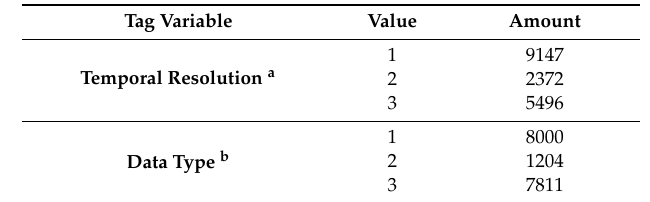
Table 1. Key information of the meta-analysis database. The amounts of measurements of each temporal resolution and each data collection type are presented in the table.